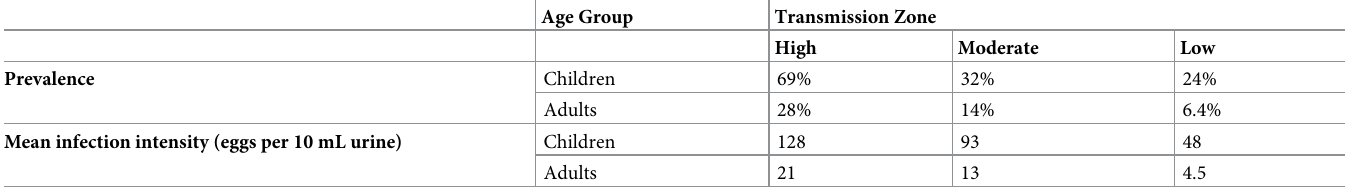
Table 1. Baseline infection levels in three surveyed Kenyan communities, classified either as high-, moderate-, or low-intensity transmission zones for S . haemato- bium infection.